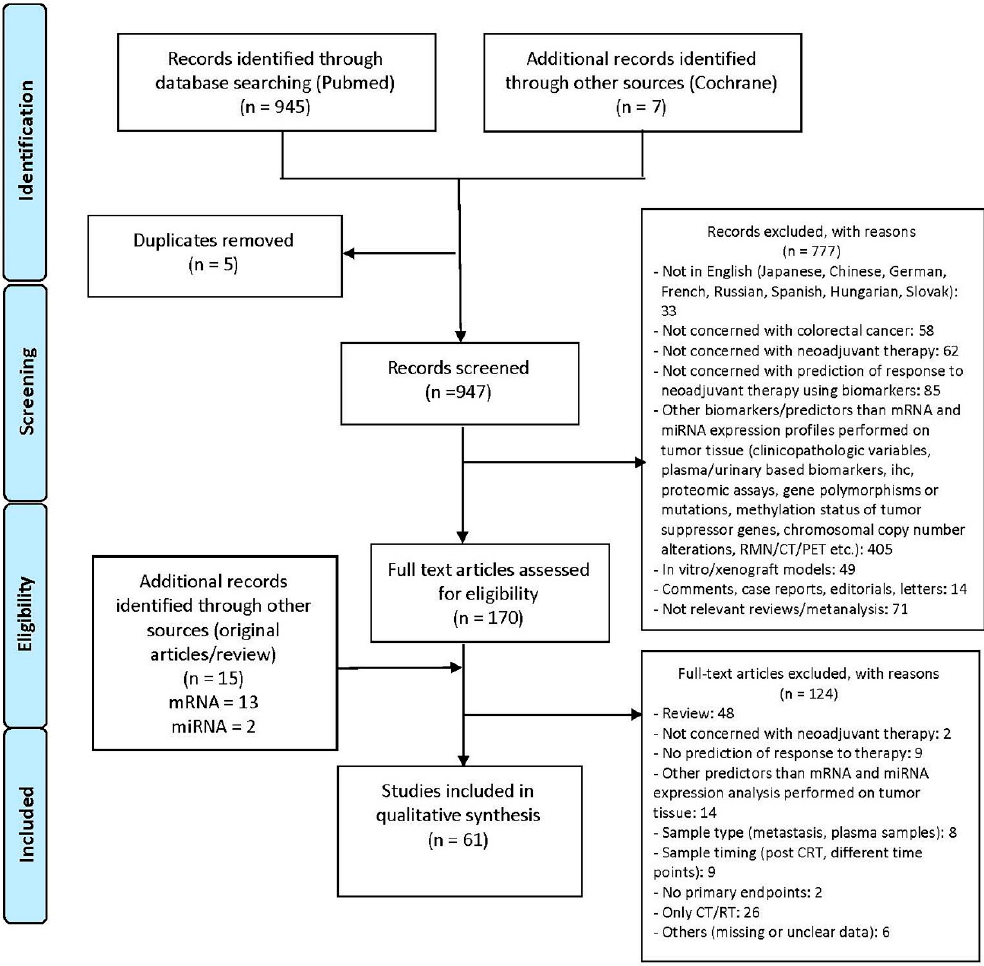
Figure 1. Flow chart reporting the procedure used to perform the systematic review.